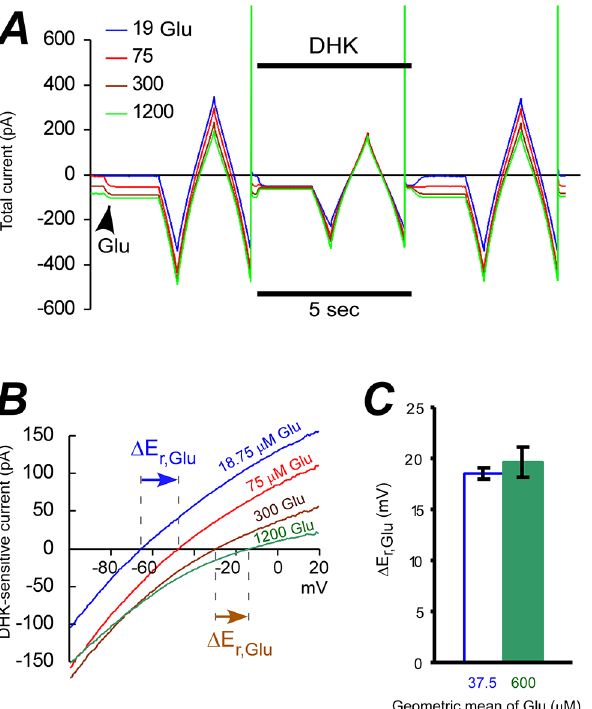
( – 100 to +20 mV) at different [Glu - ] e in the absence and the presence of DHK. Arrow head shows onset of next glutamate concentration application. (B) I-V curves of DHK sensitive currents obtained form (A) . Arrows show E rev shifts. (C) Average GLT-1 E rev shifts at [Glu - ] e geometric means of 37.5 μ M and 600 μ M are approximately equal when [Glu - ] e was increased from 18.75 to 75, or from 300 to 1200 μ M,